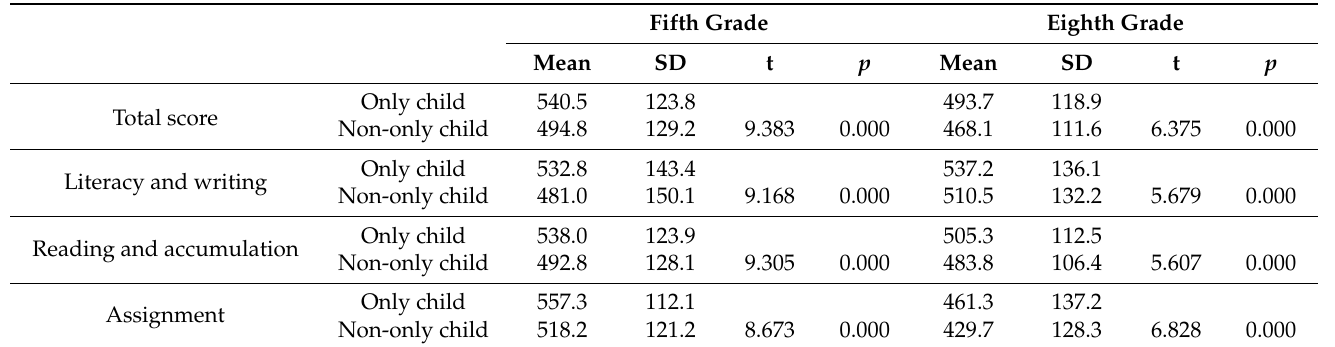
Table 11. Academic performance dimensions after matching.